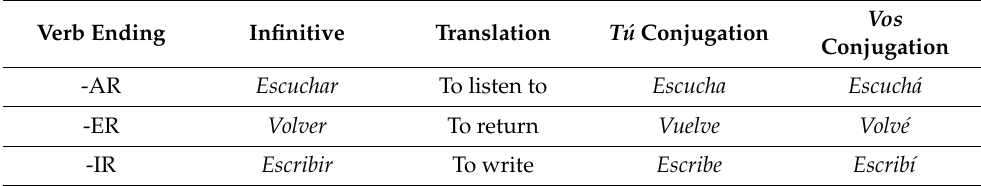
Table 3. T ú versus vos conjugations in affirmative